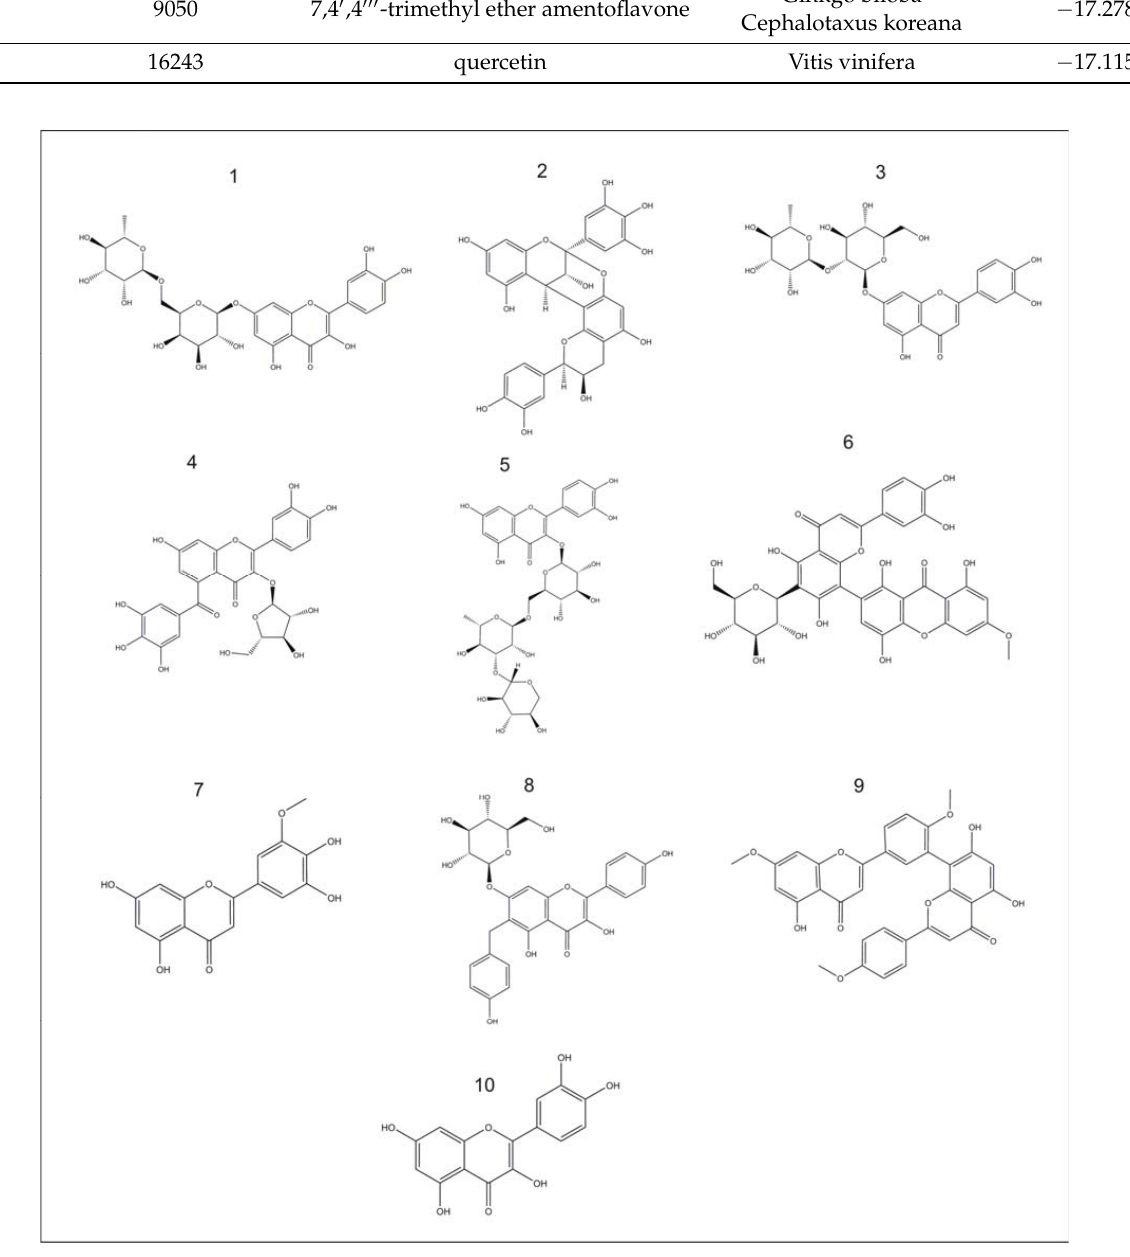
Figure 4. Structures of plant ‐ based flavonoids showing the best results in docking analysis: (1) quercetin-7-O-[ α -L-rhamnopyranosyl(1 → 6)- β -D-galactopyranoside], (2)